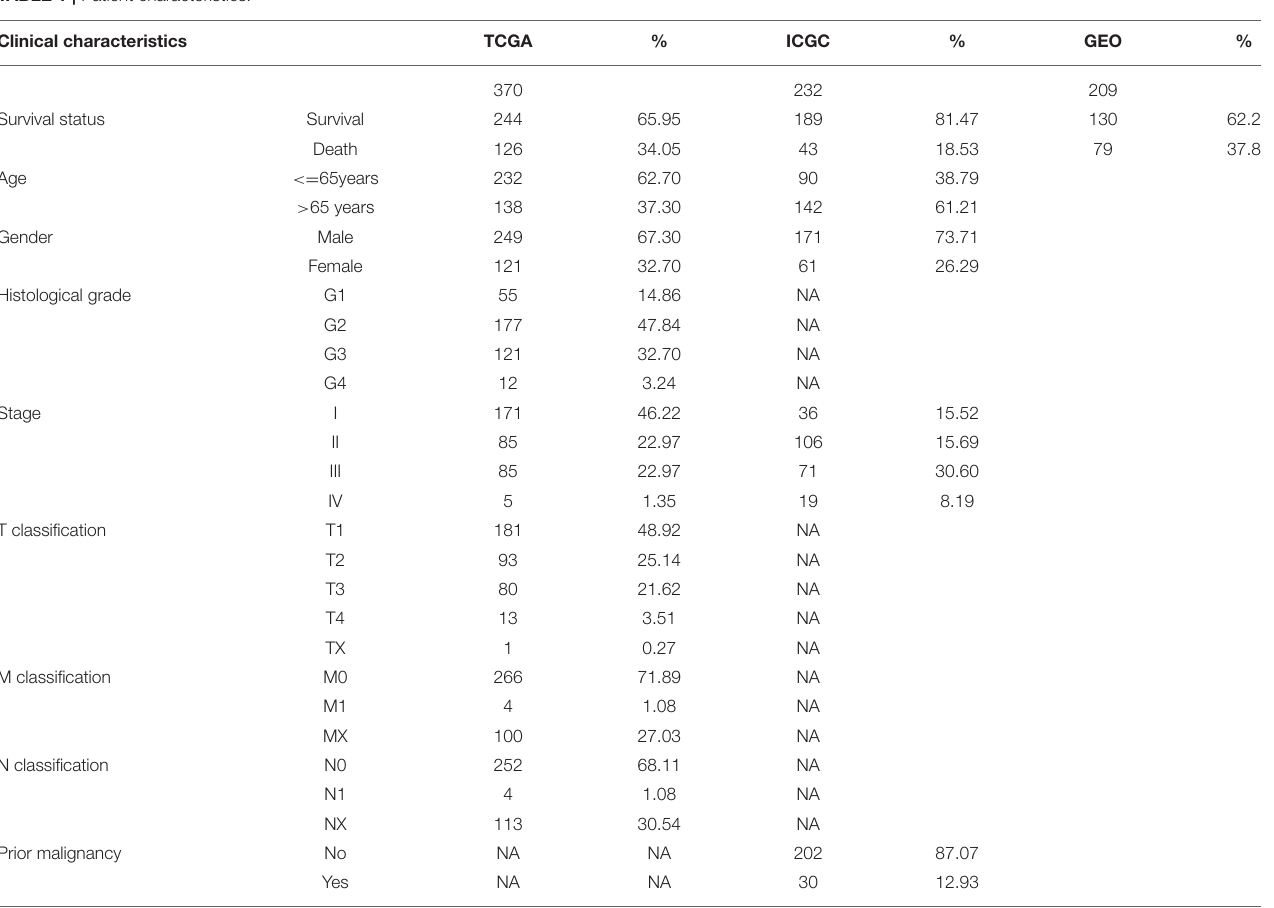
TABLE 1 | Patient